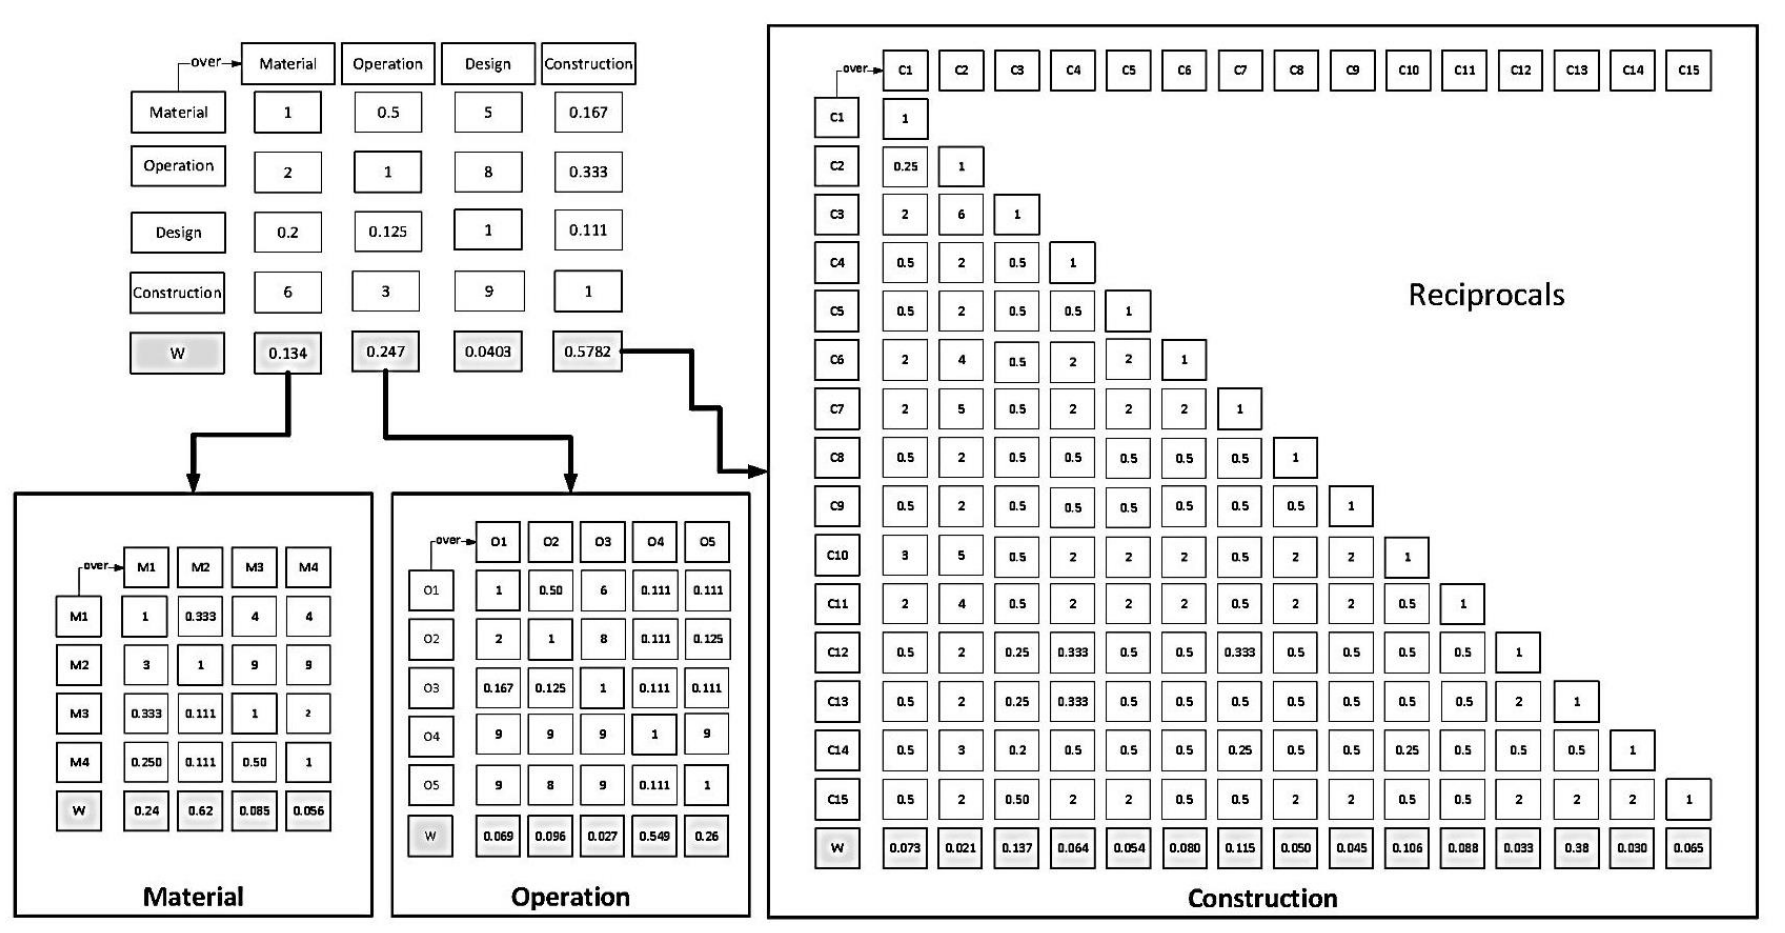
Figure 4. Pairwise comparison of rework attributes [59] .